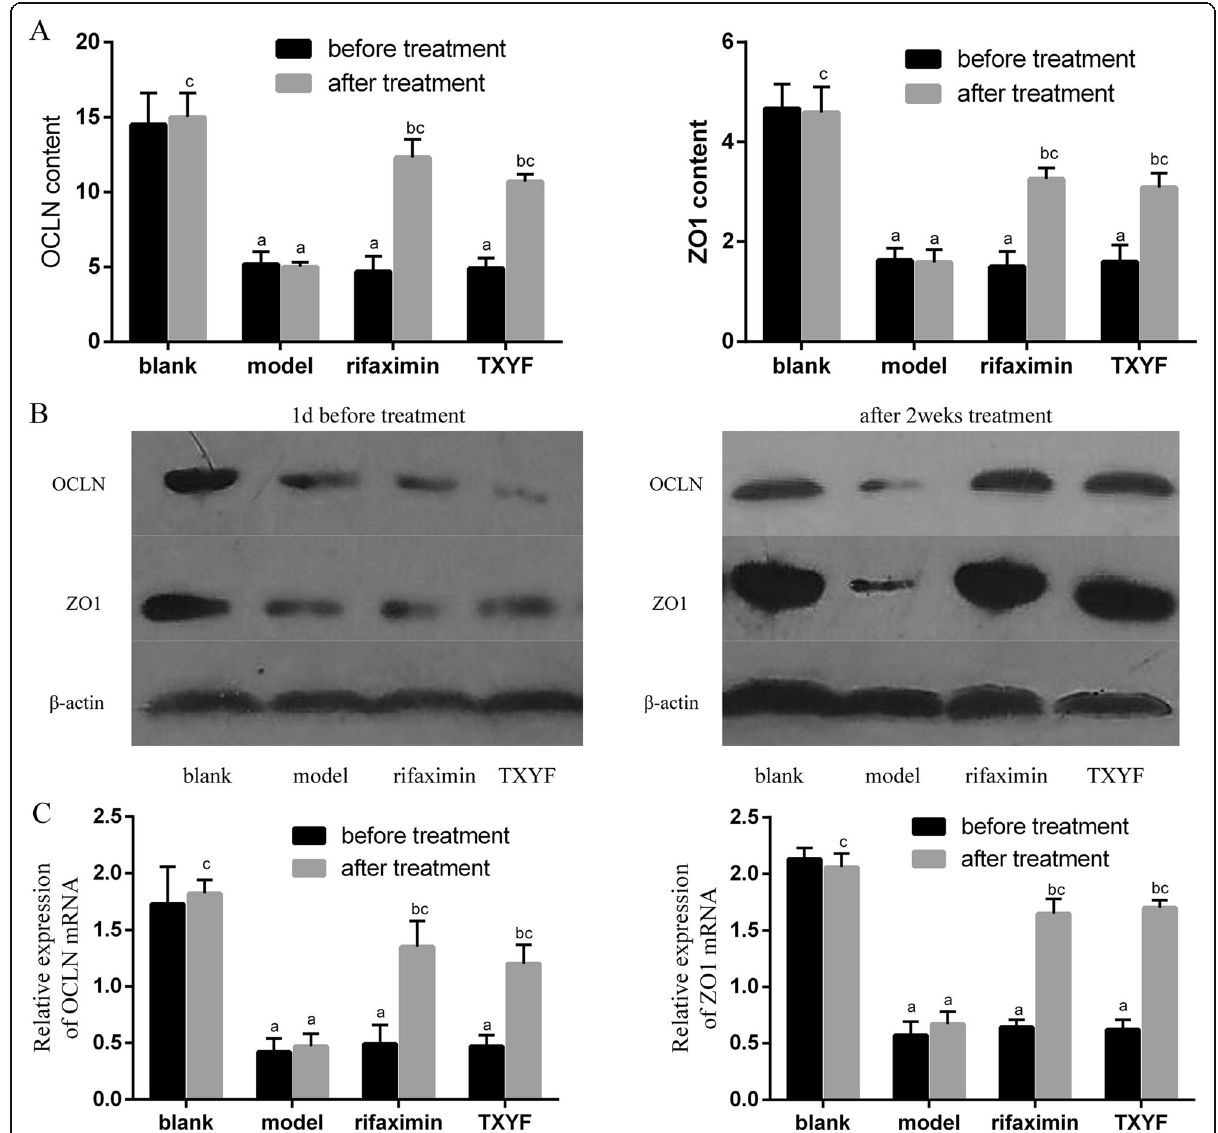
Fig. 3 TXYF protects epithelial permeability in the colon of IBS-D rats. a ELISAs showed that the OCLN and ZO1 contents were significantly decreased in the model, rifaximin and TXYF groups before treatment but increased in the rifaximin and TXYF groups after treatment. b Western blot analysis for OCLN and ZO1 in colonic tissue samples. c qRT-PCR for OCLN and ZO1 in colonic tissue samples. a P < 0.05 vs the blank group. b P < 0.05 vs before treatment. c P < 0.05 vs the model